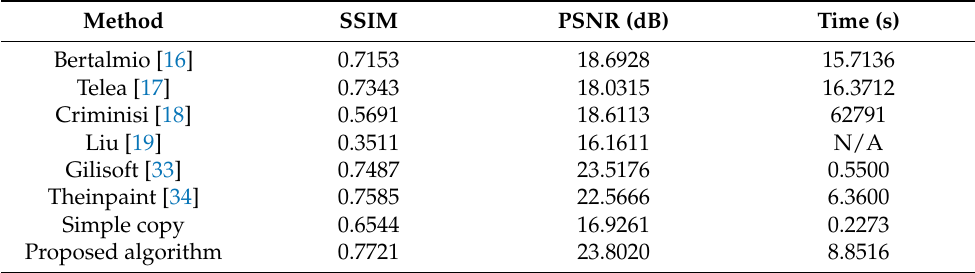
Table 3. Comparison between performances of various methods for indoor pictures (Hallway) having a large hole.